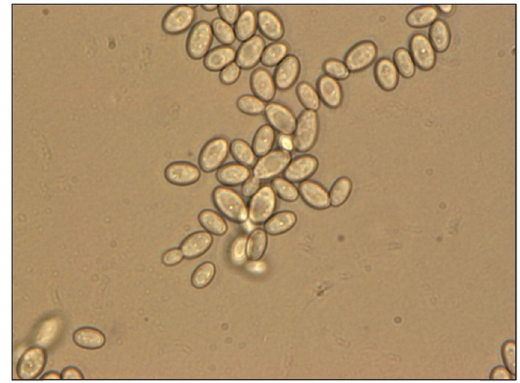
Figure 3: The cell morphology of P. kudriavzevii USM - YBP2 under light microscope showed ovoid to elongate